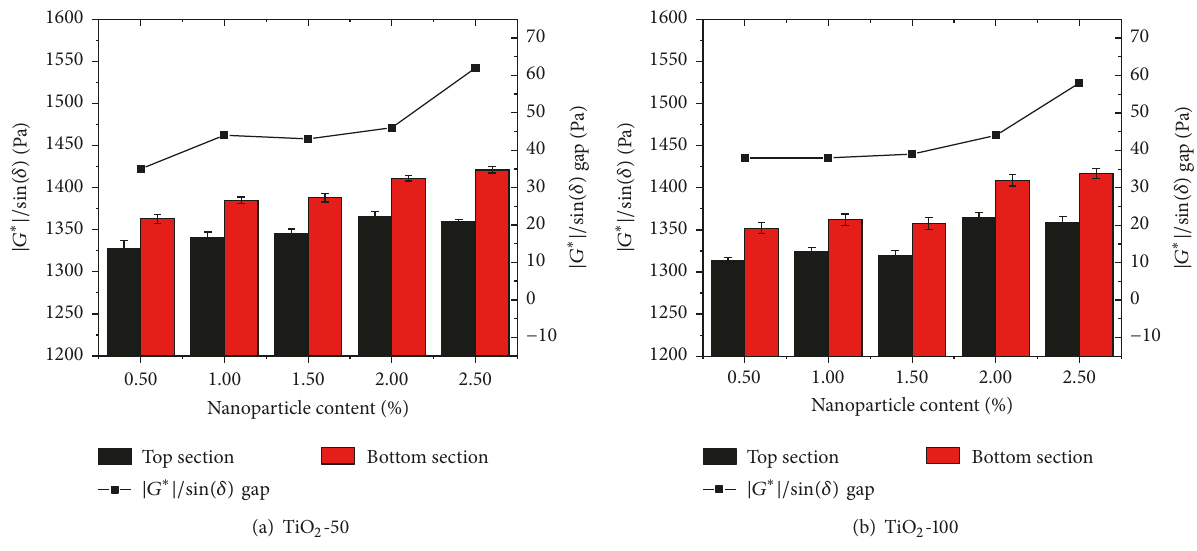
Figure 6: The effects of nanoparticle content on |𝐺 ∗ |/ sin (𝛿)